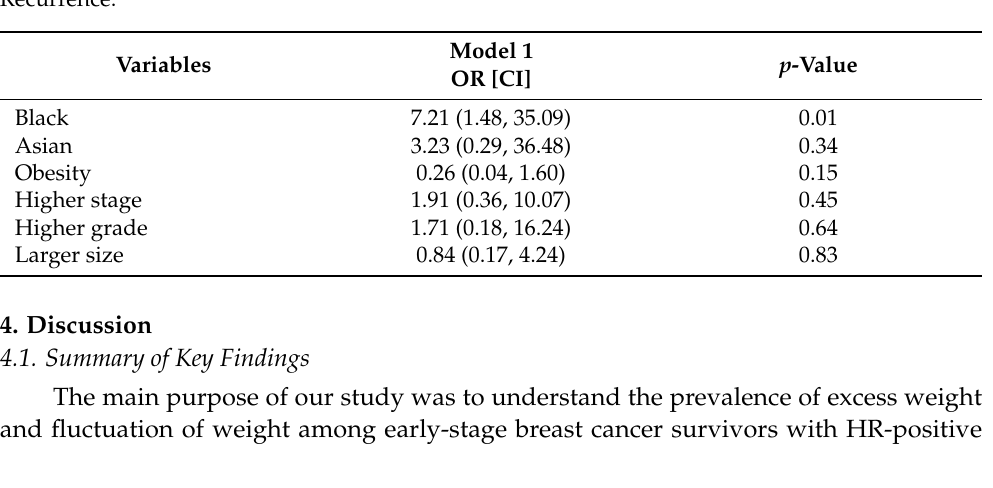
Table 3. Summary of Simple Logistic Regression Analyses for Race, Obesity and Outcome of